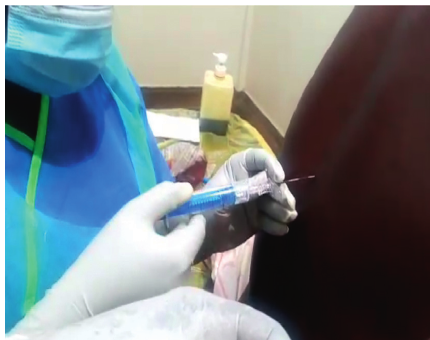
Figure 1: A wet tap during epidural placement.